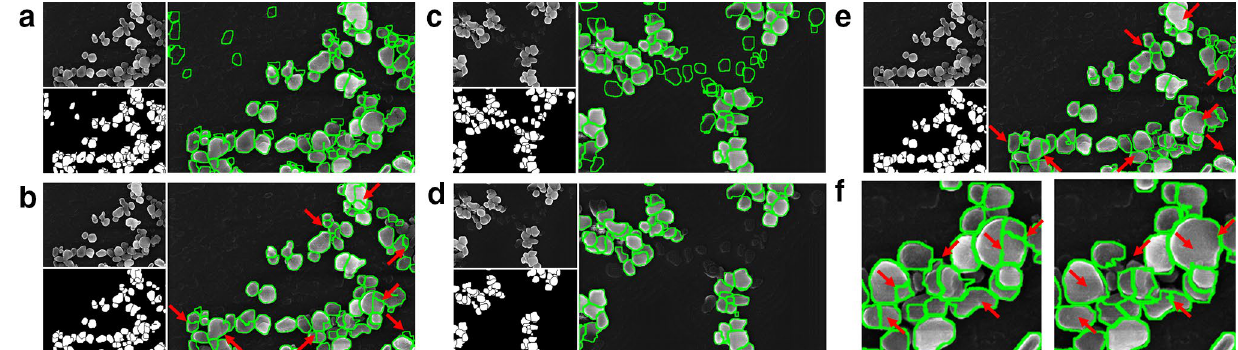
Figure 2. ( a ) Part of a real SEM image, the segmentation mask produced by cycleGAN, and the overlay. The image contains “artifact” particles, i.e., wrongly identified particle instances that only contain background pixels. ( b ) Same images as in ( a ) after a filtering step to remove artifacts. The superfluous particles were successfully filtered out, but there are still some regions with questionable segmentations, highlighted by the red arrows (see also left panel in subfigure f ). ( c ) Example of a fake SEM image generated by cycleGAN from the corresponding fake segmentation mask. As can be clearly seen in the overlay, the mask contains particle instances that are not present in the simulated SEM image. ( d ) The same image as in ( c ) after filtering. Since both the masks and the corresponding SEM images are computer generated, a virtually unlimited amount of such training data can be generated automatically for use in supervised learning of a segmentation network. ( e ) Segmentation results of the same real SEM image as in ( a ), produced by a UNet segmentation network after training on simulated data. The segmentation in the problematic areas looks more feasible. f) Zoom-in showing some of the problematic segmentations from cycleGAN (left) and the results from MultiRes UNet (right) for comparison. See also Tables 1 and S1 for quantitative comparisons. FG-rest. rand FG-rest. IT score error a. t. g error a. t.